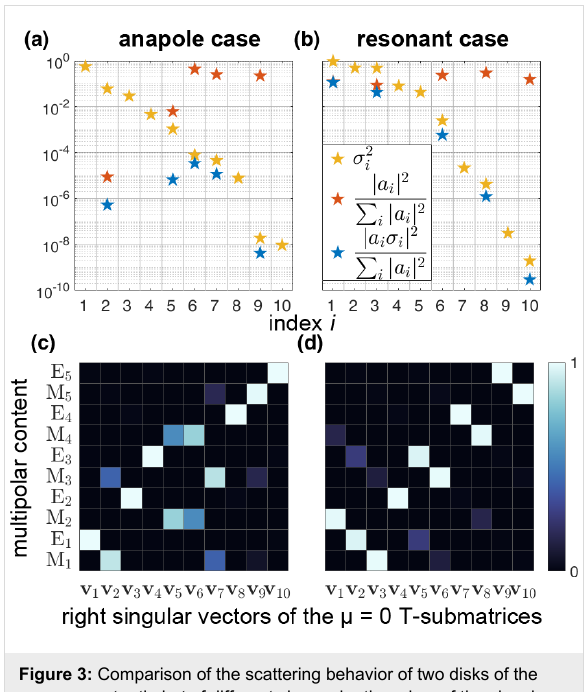
Figure 3: Comparison of the scattering behavior of two disks of the same aspect ratio but of different size under the prism of the singular value decomposition of their μ = 0 T-submatrices. One of them corre- sponds to an anapole case (a,c) and the other to a resonant case (b,d). In (a,b) we plot the singular values σ i of the T-submatrices (yellow stars), together with the coupling coefficients a i of the excita- tion field with the corresponding right singular vectors (red stars), as well as the final contribution of the correspondent singular mode to the total scattered power (blue stars). In (c,d) the multipolar content of each right singular vector v i of the two T-submatrices is plotted. Weak coupling of the external field with the first right singular vectors of the T-submatrix, that correspond to high singular values, leads to the exci- tation of the anapole